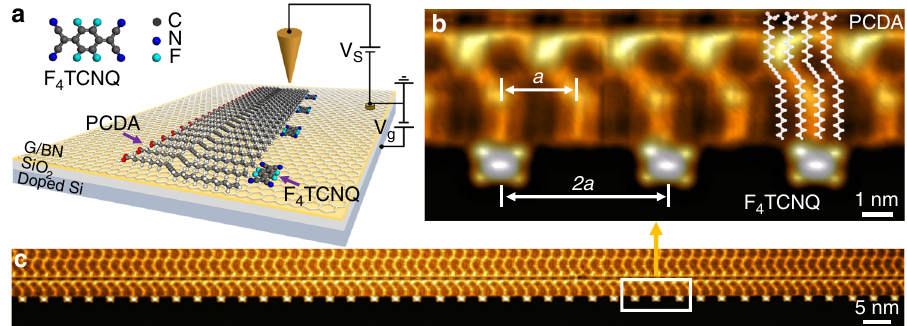
Fig. 1 STM images of one-dimensional F 4 TCNQ molecular arrays. a Schematic illustration of edge-templated synthesis of F 4 TCNQ molecular arrays on a gated graphene FET device. b A close-up view of the PCDA edge-anchored F 4 TCNQ molecular array having a period of 2 a ( a = 1.92 nm is the moiré lattice constant of the PCDA monolayer on graphene). c STM image of an 80-nm long section of an atomically precise F 4 TCNQ molecular array having the 2 a structure and anchored to the edge of a PCDA island. All STM images were acquired at T = 4.5